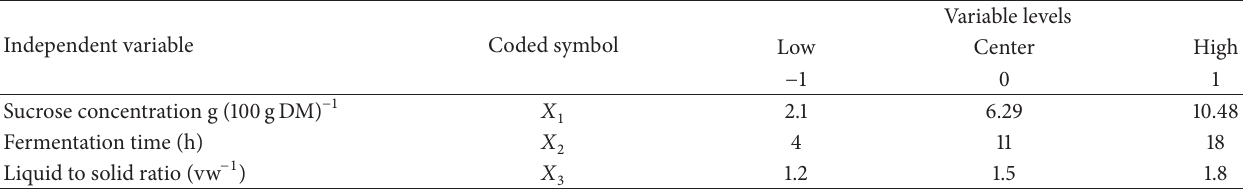
Table 1: Levels and code of independent variables used for Box-Behnken experimental